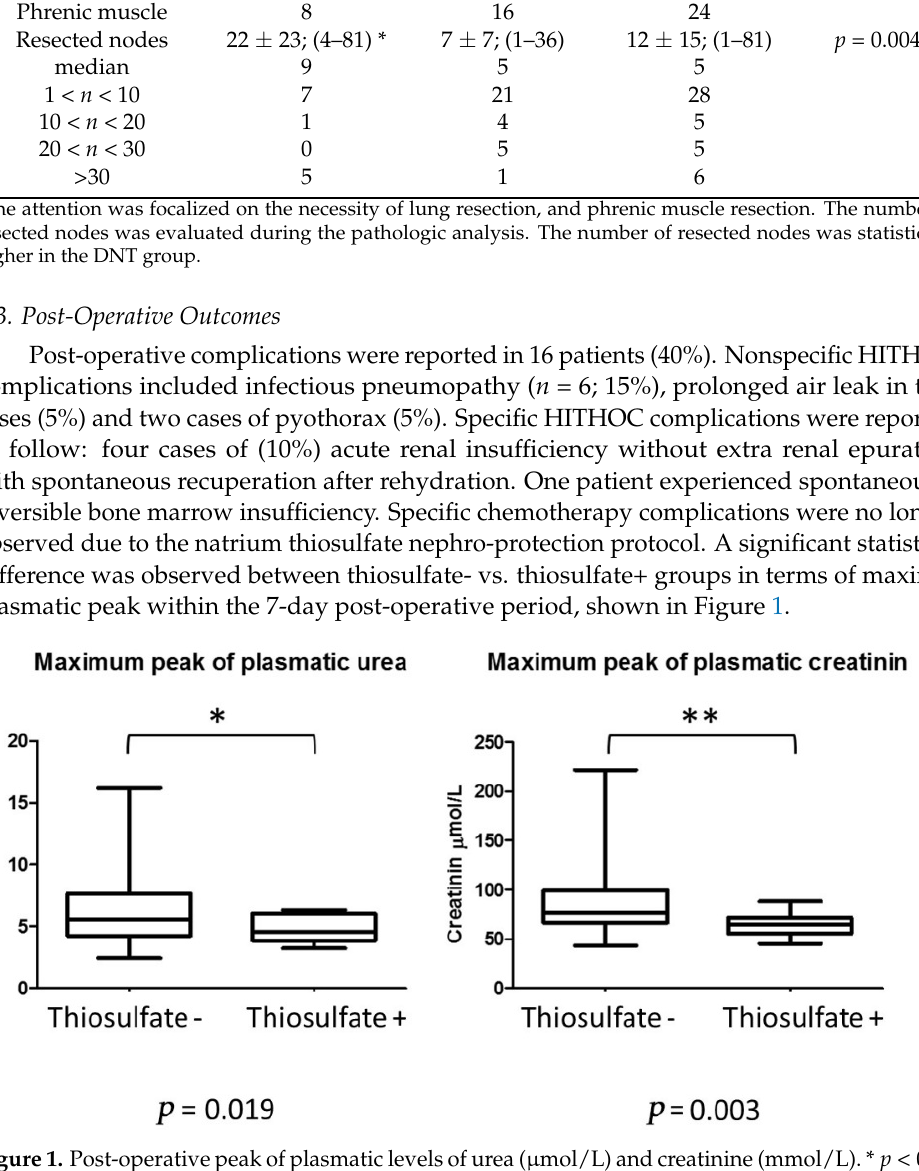
Figure 1. Post-operative peak of plasmatic levels of urea ( µ mol/L) and creatinine (mmol/L). * p < 0.05; ** p < 0.001.